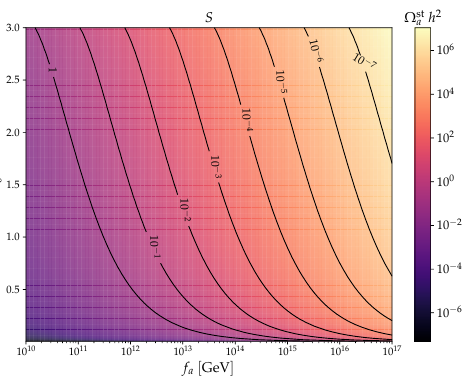
Figure 5 . Contours in the plane of f a and the initial misalignment angle θ 0 of the S necessary to bring the standard cosmology axion relic abundance (indicated by the color map) into agreement with the observed density of dark